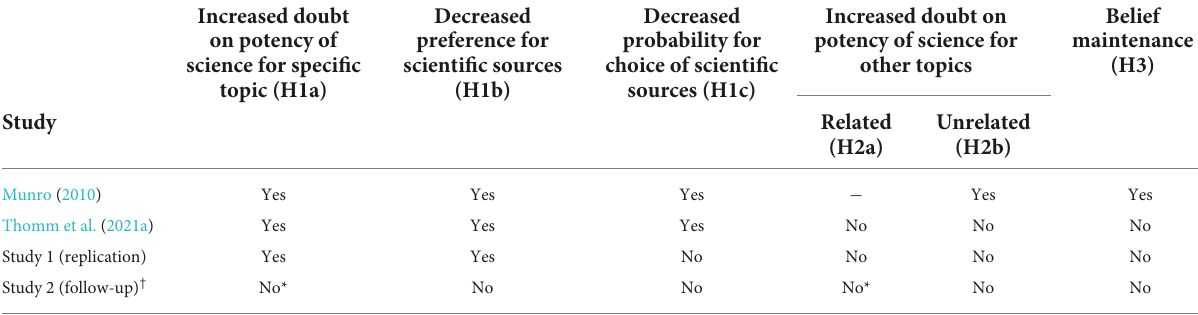
TABLE 3 Comparison of findings on hypotheses about effects of the scientific impotence